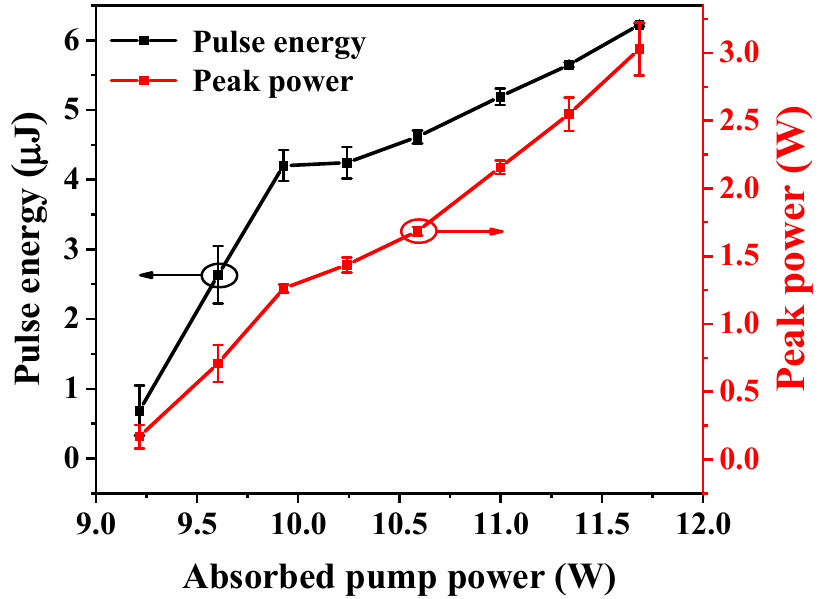
Figure 4. Single pulse energy and peak power vs. the absorbed pump power. Figure 5 shows the pulse profile when the absorbed pump power reached the threshold. The pulse width was 4.06 µ s and the illustration of Figure 5 shows the corresponding pulse sequence. When the absorbed pump power reached 11.7 W, the pulse width decreased to 2.06 µ